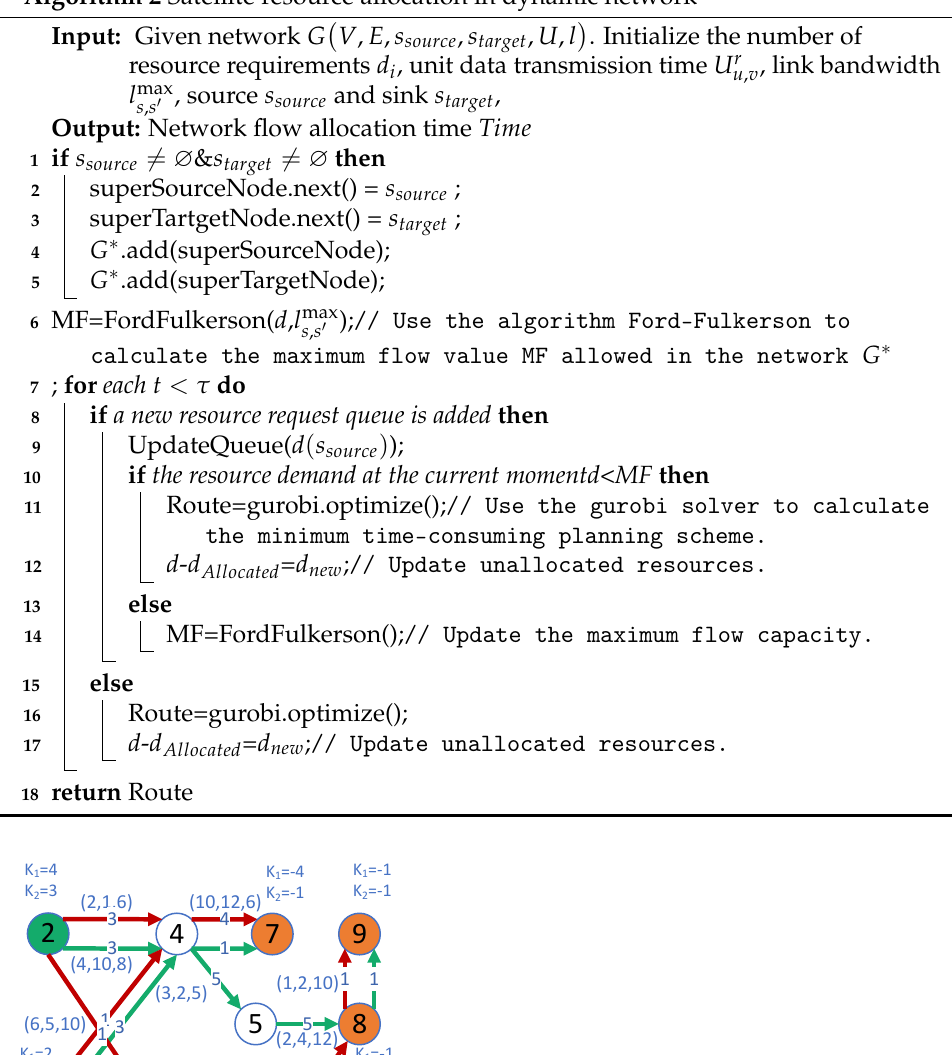
Algorithm 2 Satellite resource allocation in dynamic network